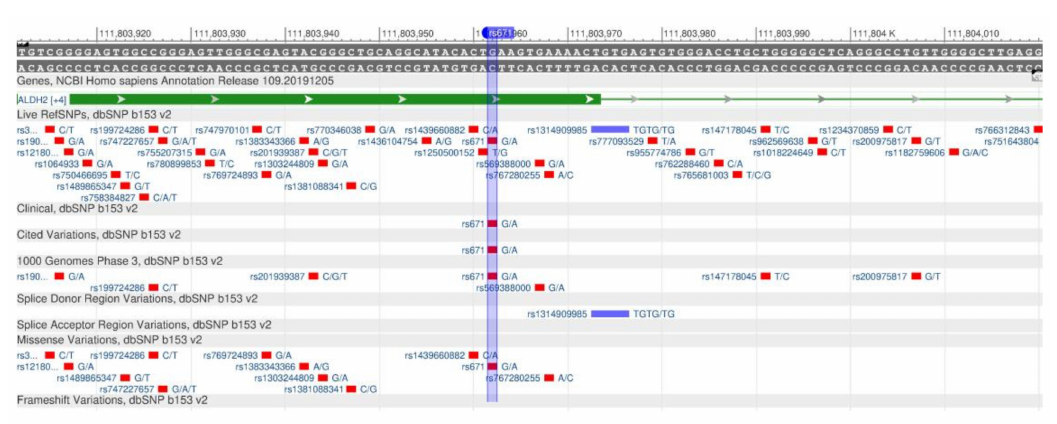
Figure 37. A section of the ALDH2 gene (located on the long (q) arm of chromosome 12) containing the oligonucleotide polymorphism rs671.